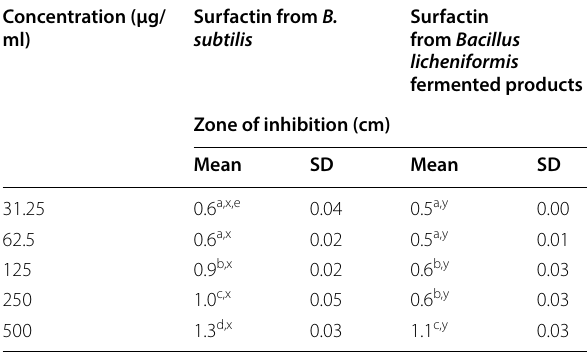
Table 4 Measurement of zone of inhibition of surfactin on C. perfringens growth at different